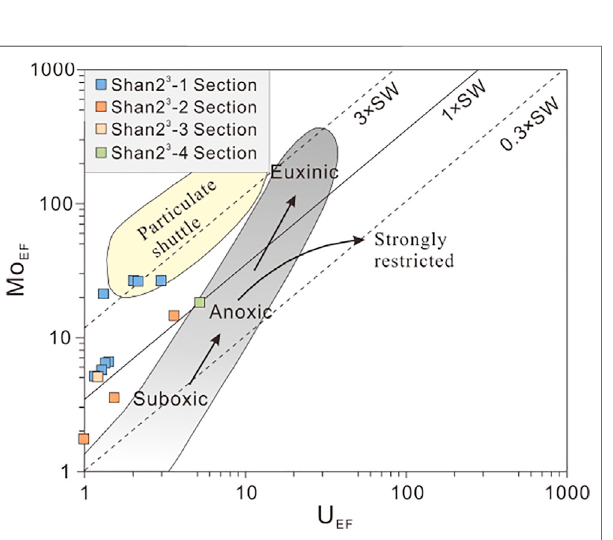
FIGURE 8 | (A) Correlation between Sr/Ba ratios and CaO content for Shanxi Formation Shan 2 3 Submember shale. (B) Paleo-water salinity facies for Shanxi Formation Shan 2 3 Submember shale.